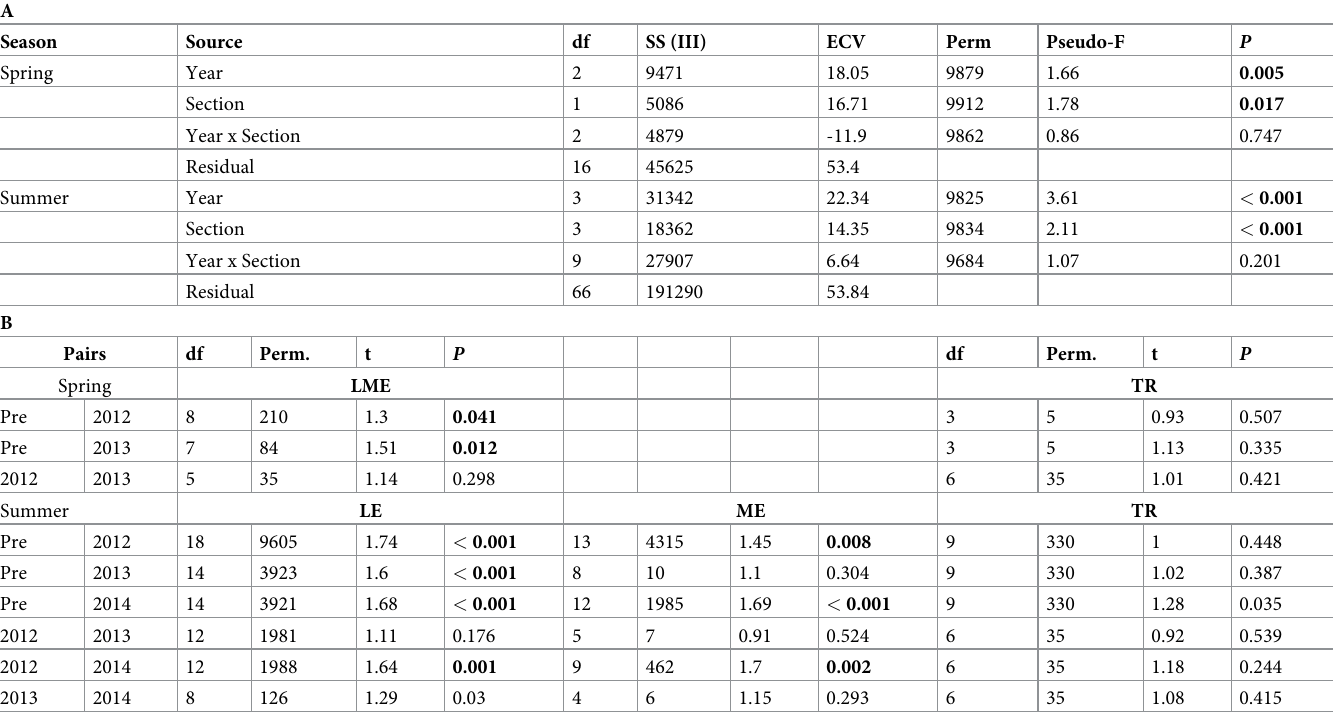
Table 9. River PERMANOVA results for spring and summer fish diet composition for: (a) Main tests of year, section, and year x section effects, and (b) Pairwise comparisons for year x section